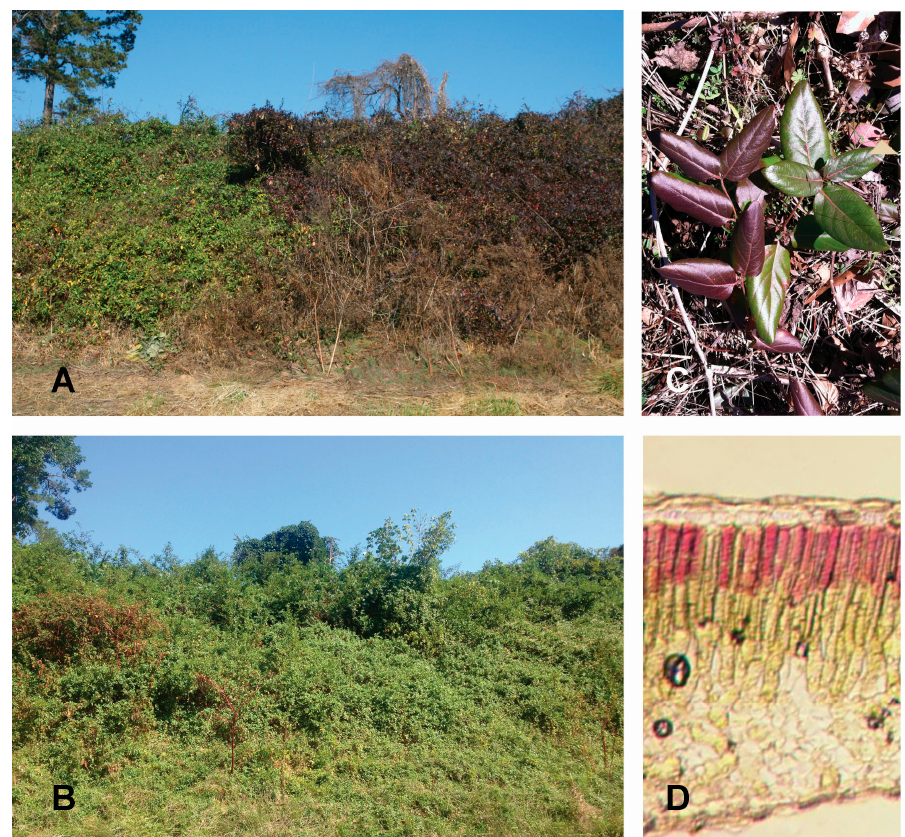
Figure 6. Photographs of Lonicera japonica . ( A ) I40 site during winter; green ( left ) and red ( right ) “color sides” are visibly distinct; ( B ) I40 site during summer; all L. japonica individuals presenting with green leaves; ( C ) Co-occurring red and green individuals of L. japonica as found in situ at RR; ( D ) Cross section of red L. japonica leaf, with anthocyanin pigments in the uppermost palisade